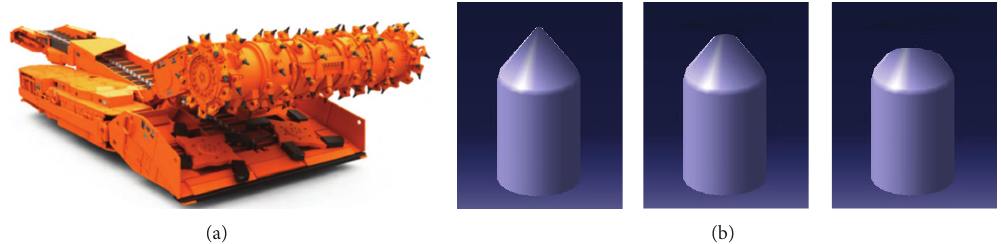
Figure 1: (a) Continuous miner machine (courtesy: joy global) [27]; (b) gradual wear of WC-Co